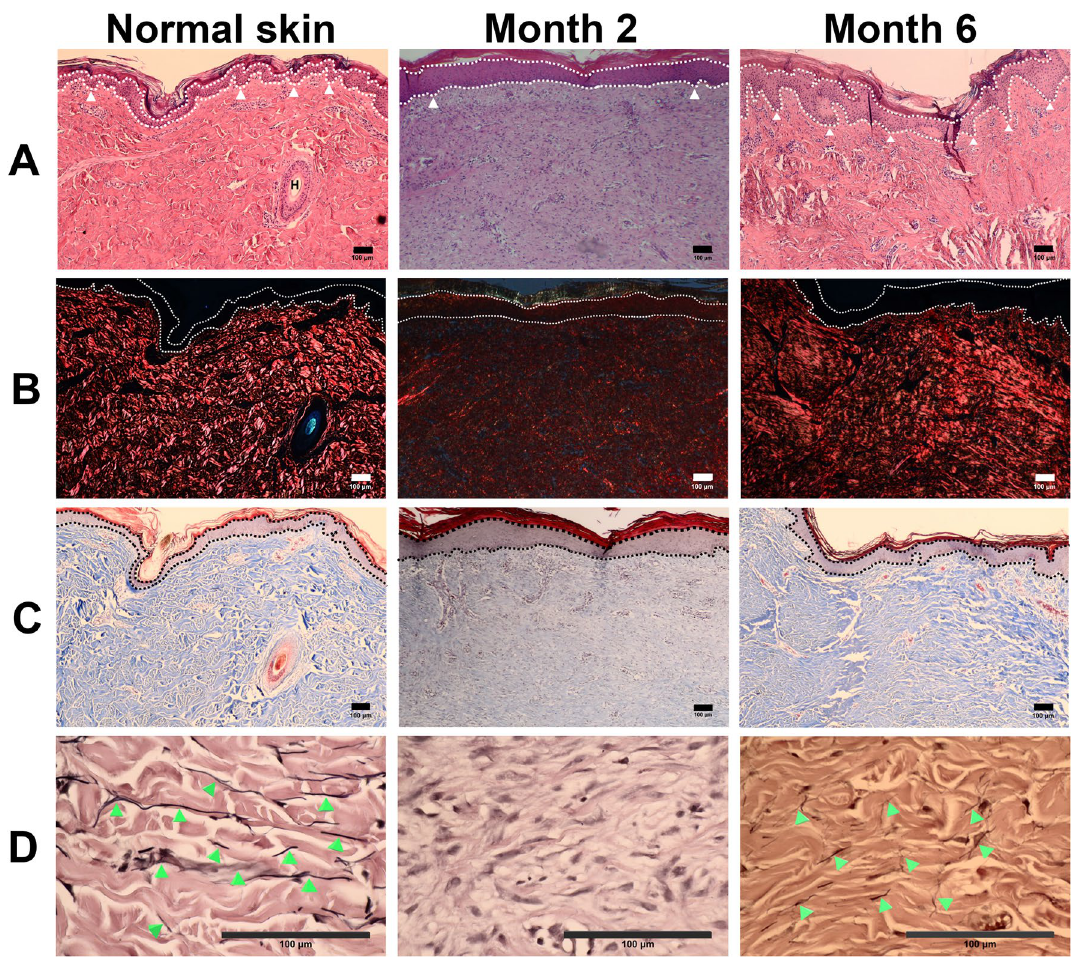
Figure 7. Histological micrographs of normal skin and regenerated skin tissues at months 2 and 6 postoperatively for full-thickness wounds of 2.5 cm × 2.5 cm × 0.6 cm. White dotted lines in ( A , B ) and black dotted lines in ( C ) indicate epidermal layers. ( A ) Hematoxylin and eosin-stained micrographs indicate changes in thickness and rete ridges of the epidermis. The rete ridges are indicated by white triangles. The hair follicle is indicated as “H”. ( B ) Picrosirius red staining of polarized micrographs indicates collagen distribution in the dermis. ( C ) Masson’s trichrome staining illustrates collagen biosynthesis in blue color in the dermis. ( D ) Verhoeff’s staining illustrates elastin fibrils in dark brown as indicated by green triangles (bar = 100